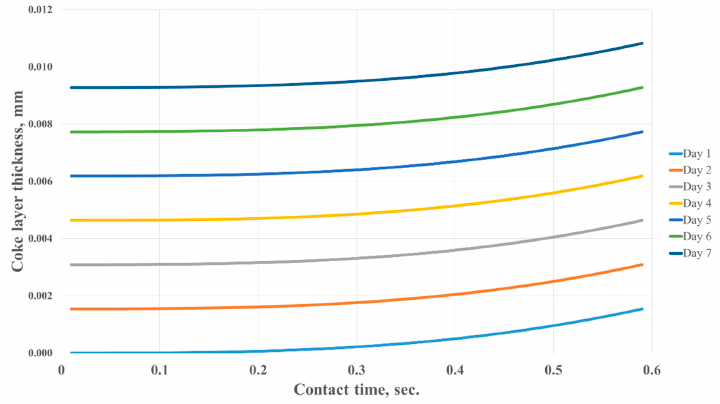
Figure 6. Change of the coke layer thickness with a reduced contact time.